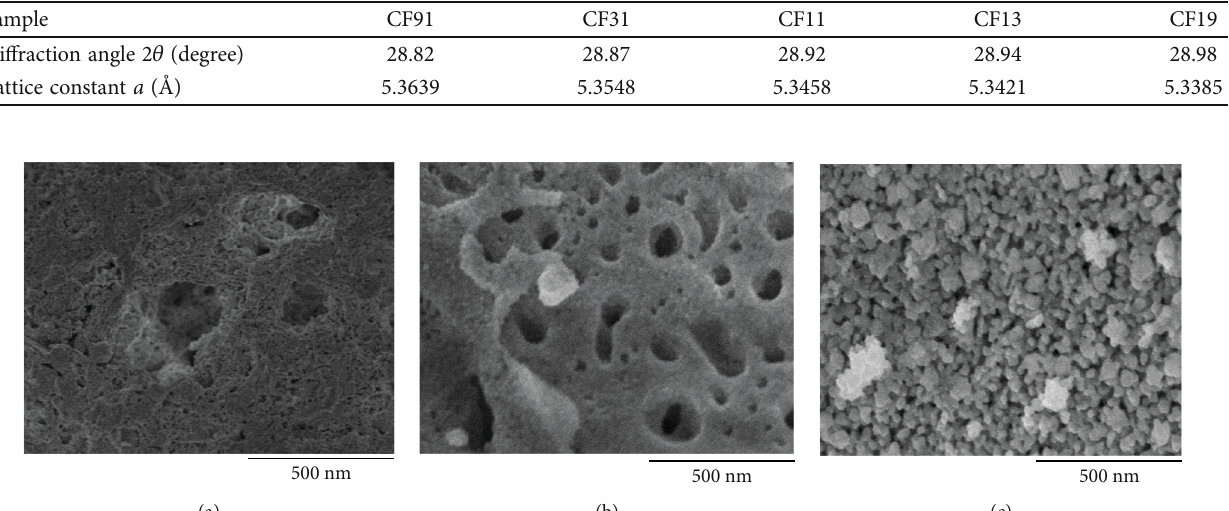
Figure 5: SEM images of CeO